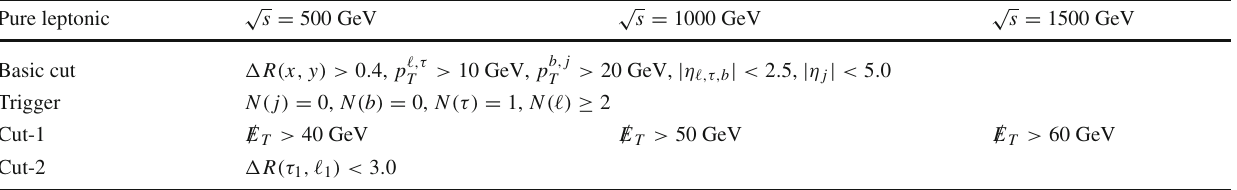
Table 4 Cut flows of the signal and backgrounds at m τ (cid:2)± = 200 GeV, √ s = 500 GeV Pure leptonic